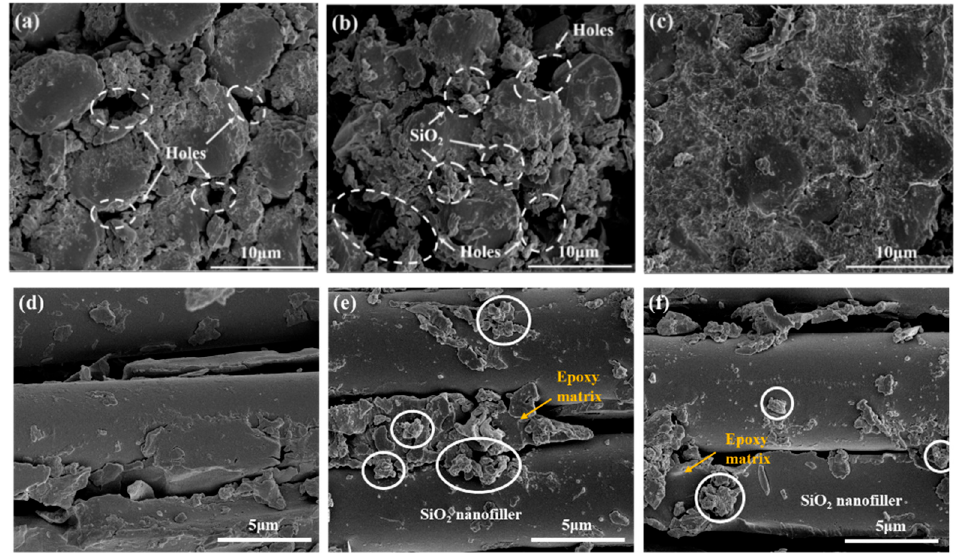
Figure 3. SEM characterization of axial direction of GFRP section. ( a ) GFRP. ( b ) SiO 2 -GFRP. ( c ) FSiO 2 -GFRP. SEM characterization of radial direction of GFRP section. ( d ) GFRP. ( e ) SiO 2 -GFRP. ( f ) FSiO 2 -GFRP.